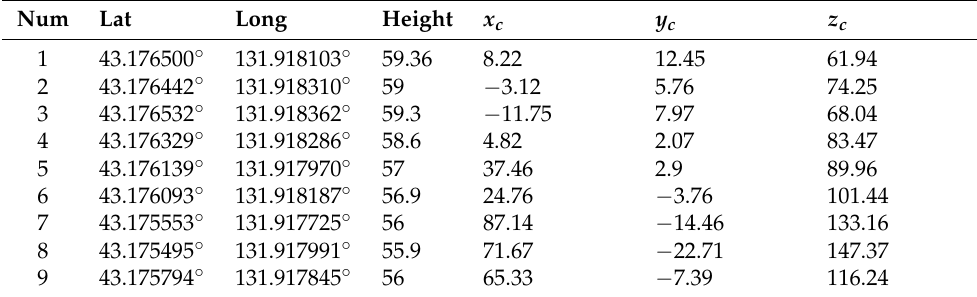
Table 2. The spatial points used for the road plane approximation (global and F c coordinates); F c coordinates are in meters.